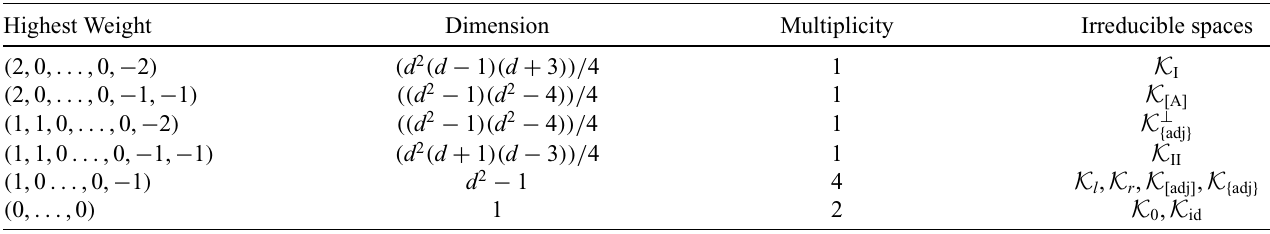
TABLE IX. Irreducible representations for a multiqubit system, where d = 2 q . The definitions of the irreducible spaces are based on the irreps of the Clifford group given in Ref. [ 100], and are explained in the main text. Highest Weight Dimension Multiplicity Irreducible